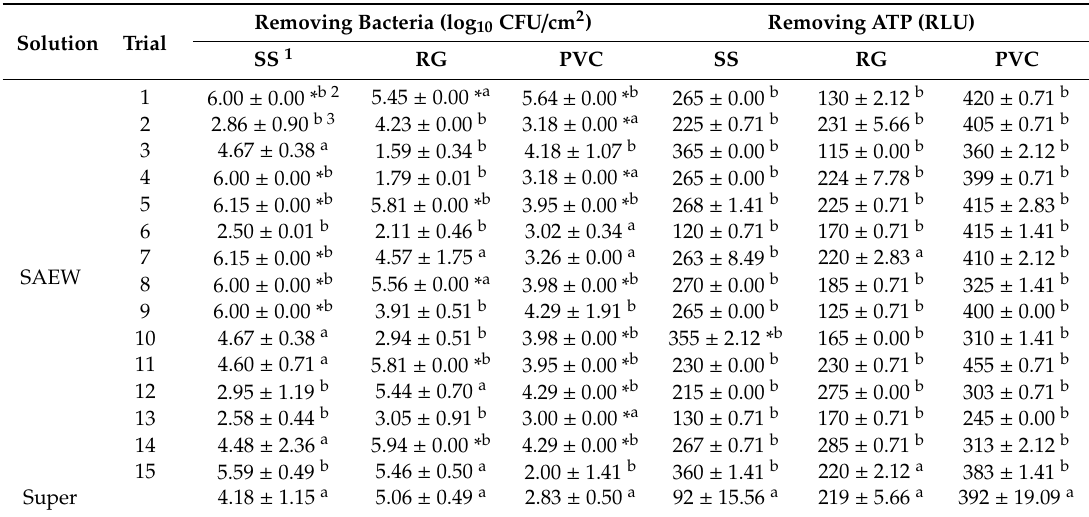
Table 4. Bacteria and ATP removal from three materials with the SAEW and “super” treatments. Solution